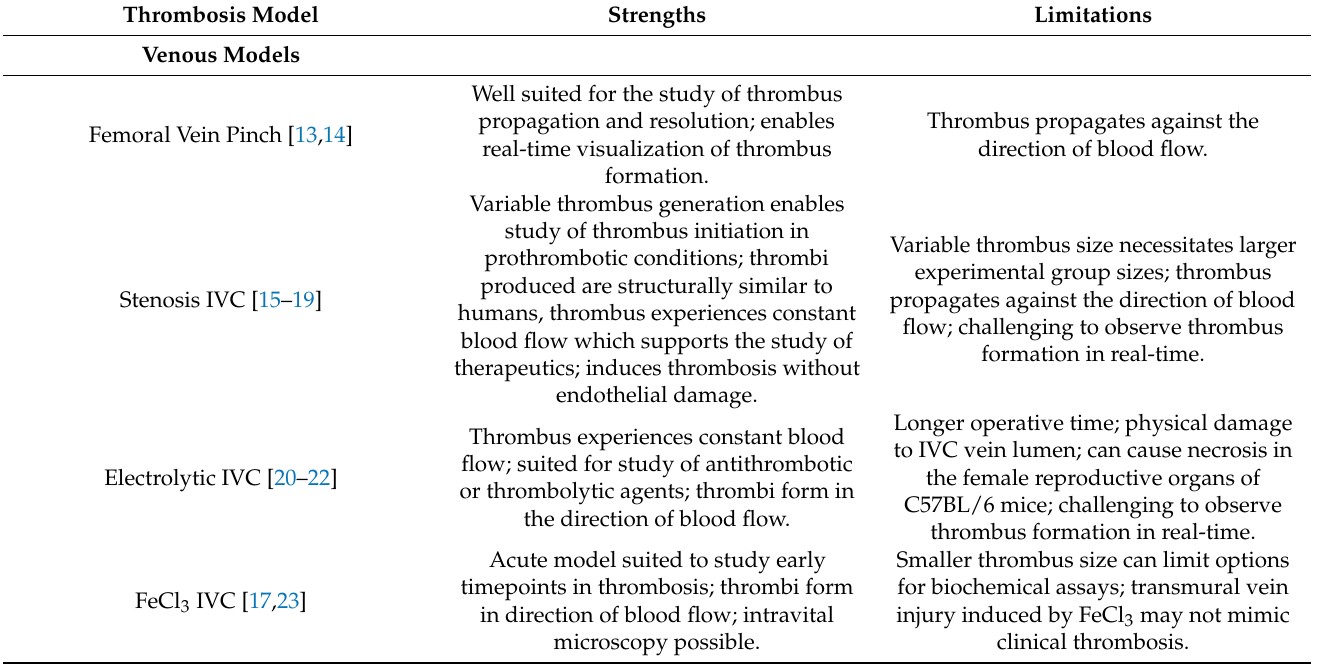
Table 1. Strengths and limitations of various animal models of APS thrombosis. Thrombosis